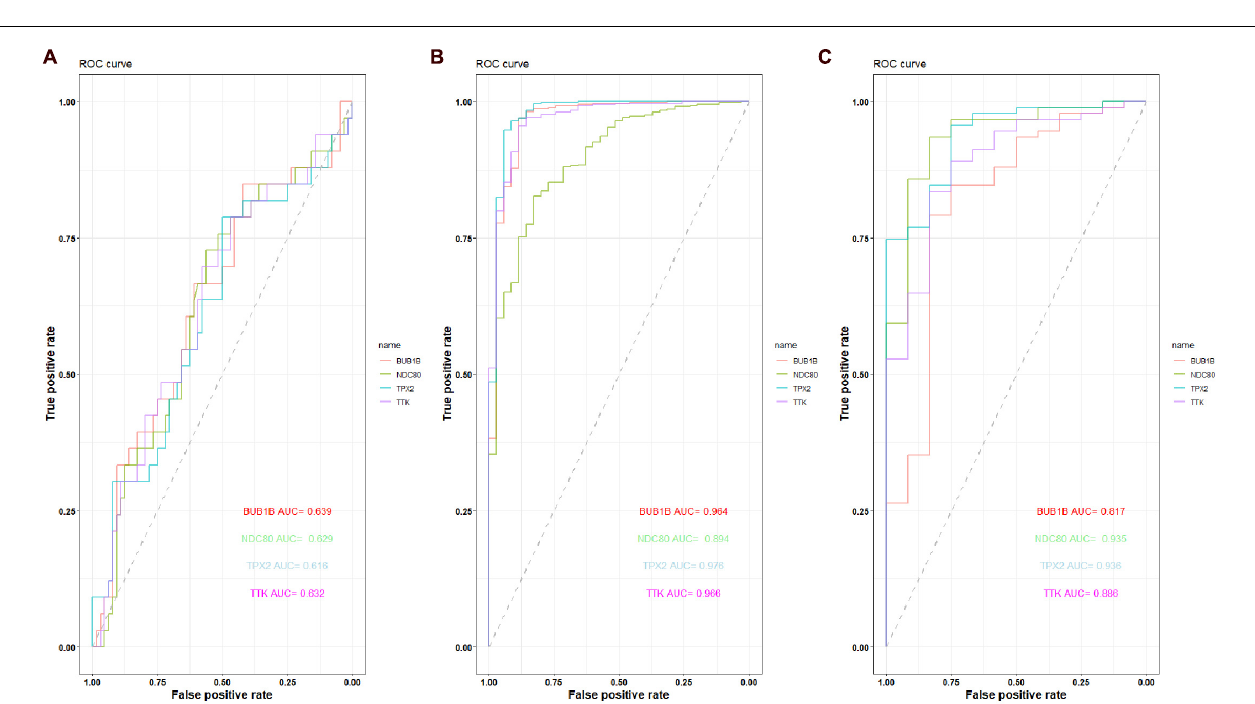
FIGURE 13 | Receiver operating characteristic (ROC) curve of the capacity of BUB1B, NDC80, TPX2, and TTK in distinguishing between EC, EH, or normal tissue. (A) ROC curve of the capacity of BUB1B, NDC80, TPX2, and TTK in distinguishing between EC and EH in the GSE106191 dataset. (B) ROC curve of the capacity of BUB1B, NDC80, TPX2, and TTK in distinguishing between EC and normal tissue in the UCEC dataset. (C) ROC curve of the capacity of BUB1B, NDC80, TPX2, and TTK in distinguishing between EC and normal tissue in the GSE17025 dataset.